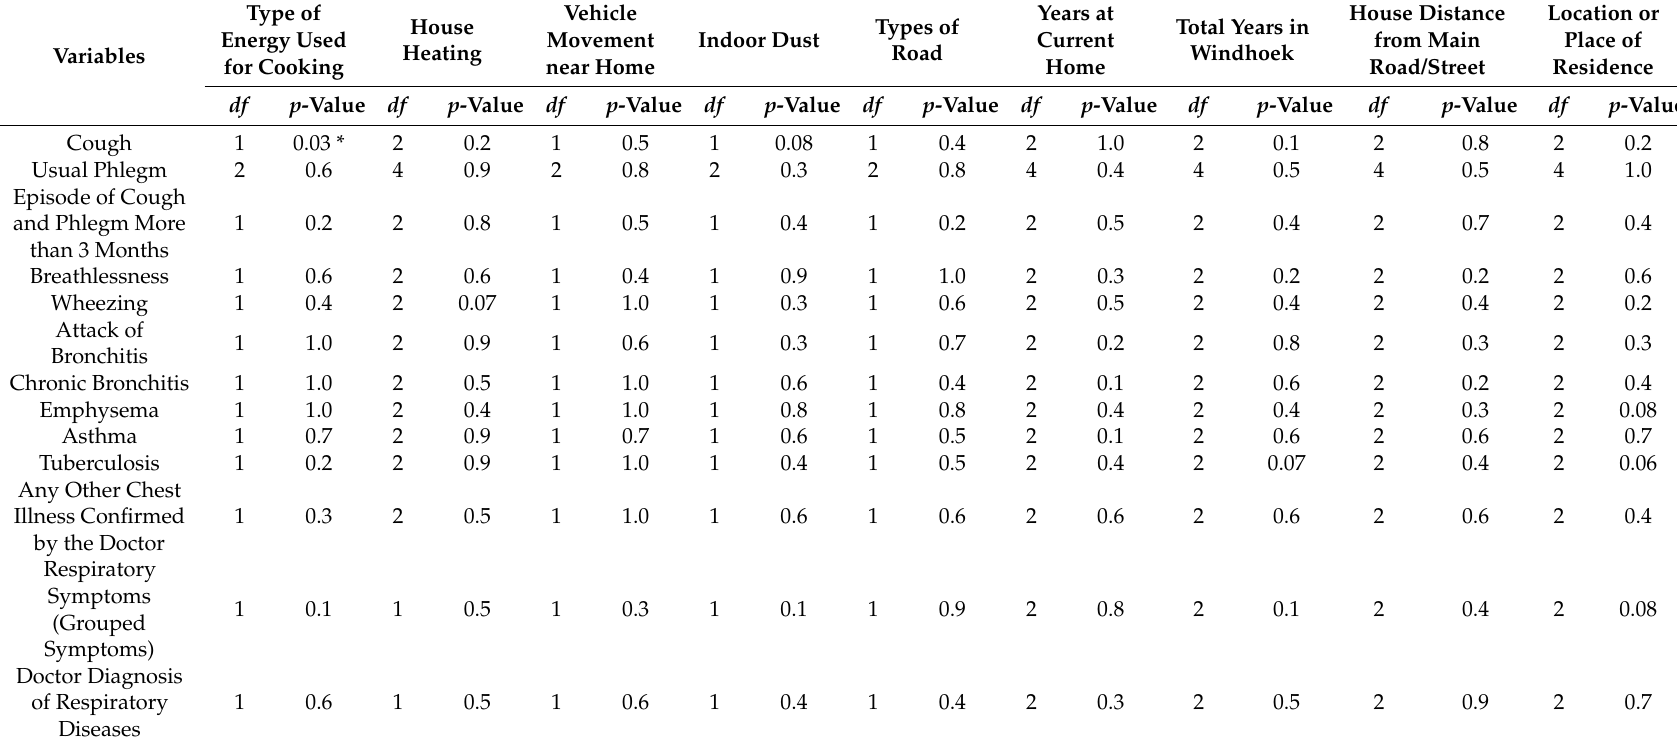
Table 7. Association between respiratory disorders and PM concentration and